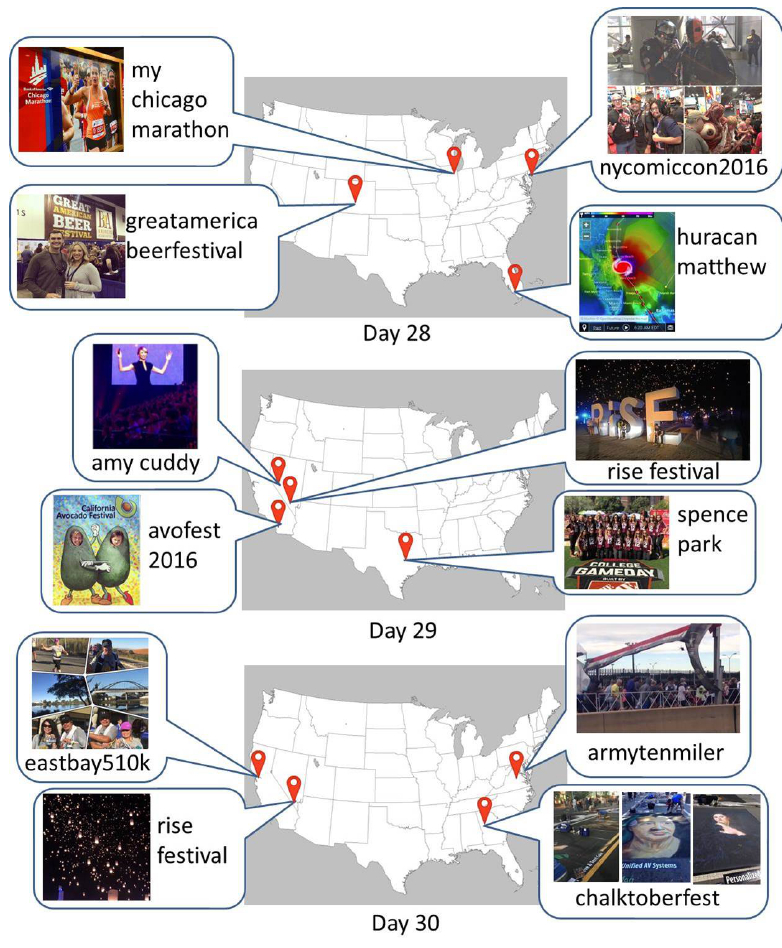
Figure 19. Examples of the temporary local words only in our geographic dictionary on different days.